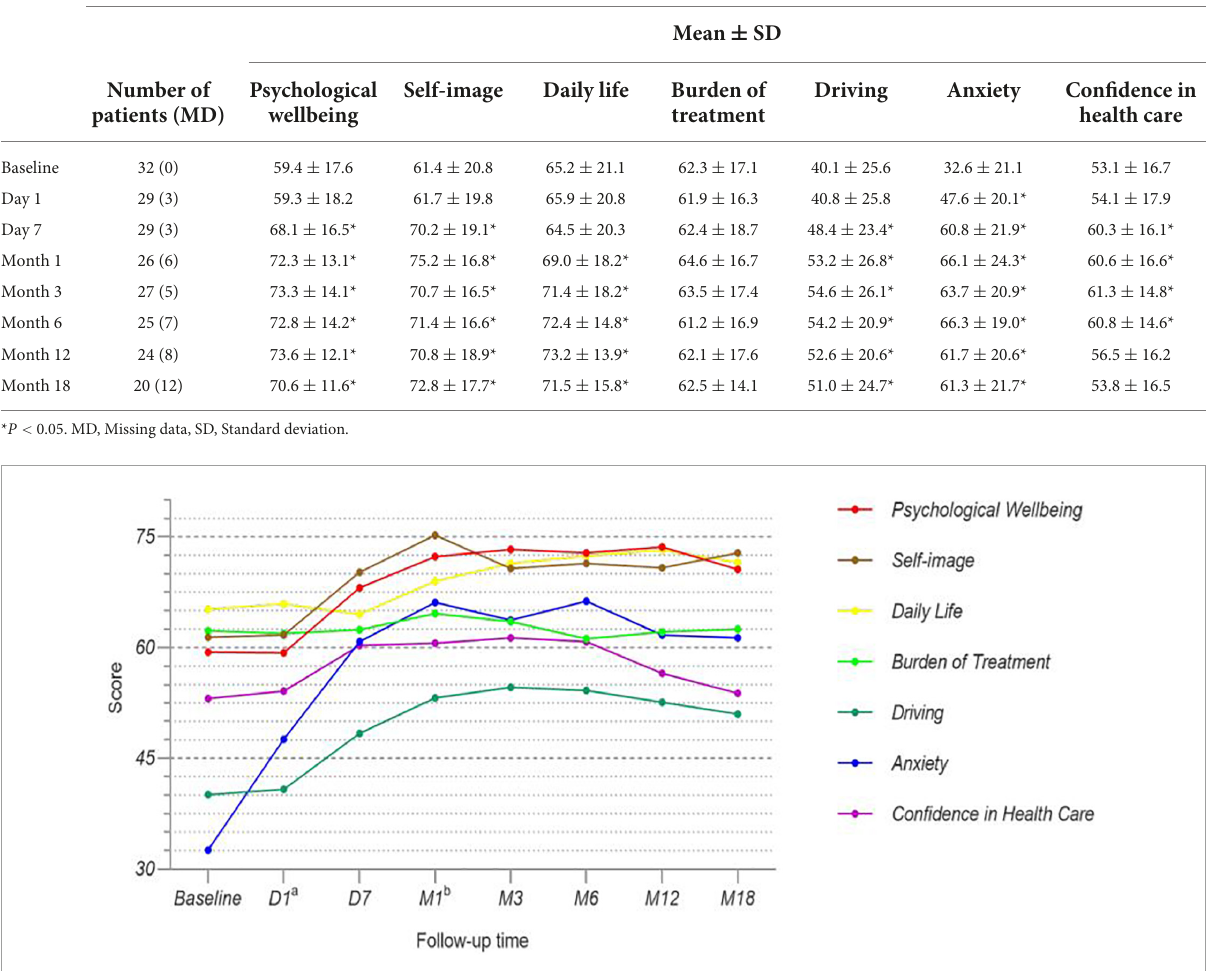
FIGURE3 Each survival index in all